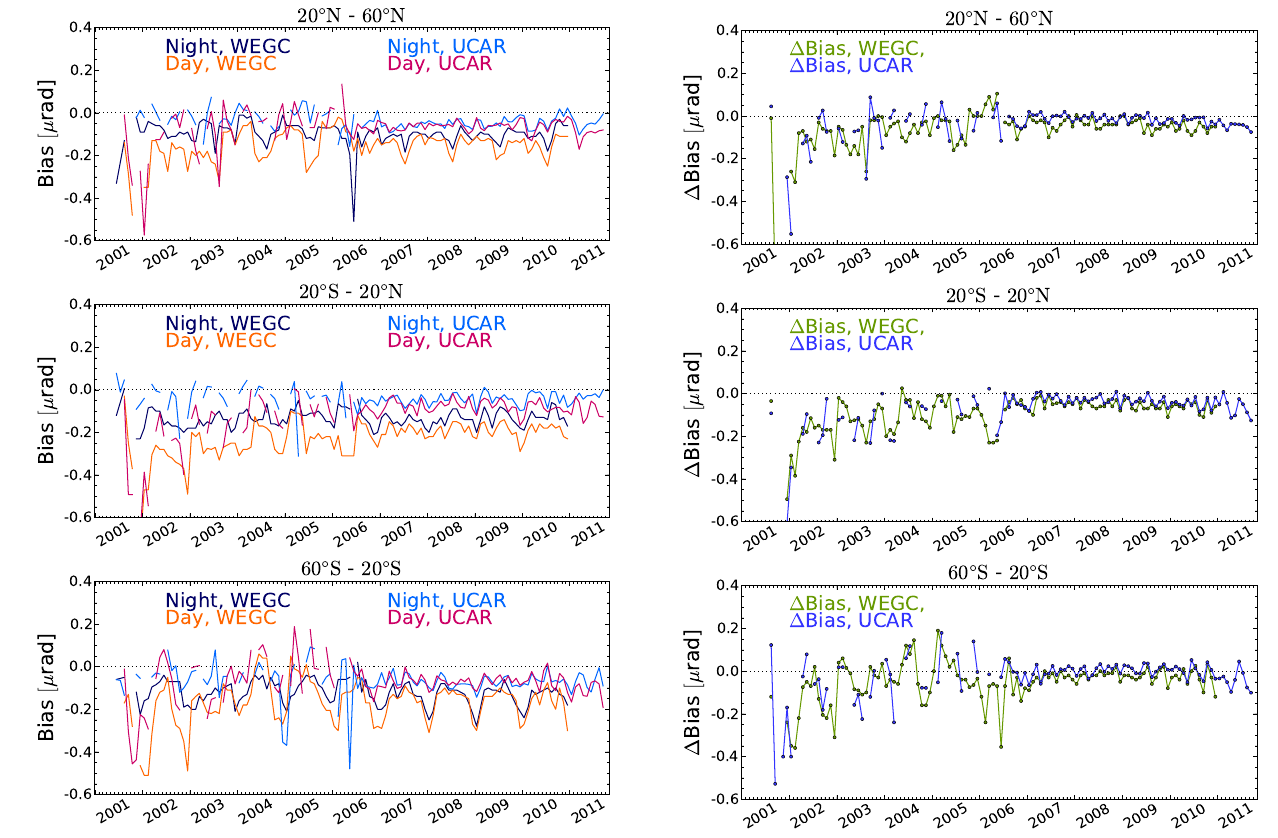
Fig. 4. Difference between daytime and nighttime bending angle bias for three latitude zones, comparing WEGC (green line) and UCAR (blue line) bending angle data (same latitude zone as in Fig. 3). bending angle bias for three latitude zones, com- bending angle bias for three latitude zones, com- paring WEGC (green line) and UCAR (blue line) paring WEGC (green line) and UCAR (blue line) 2010. We find that the data of the two satellites are in good bending angle data (same latitude zone as in bending angle data (same latitude zone as in agreement in the overlapping period from August 2006 Fig. 3). Fig. 3). 25 25